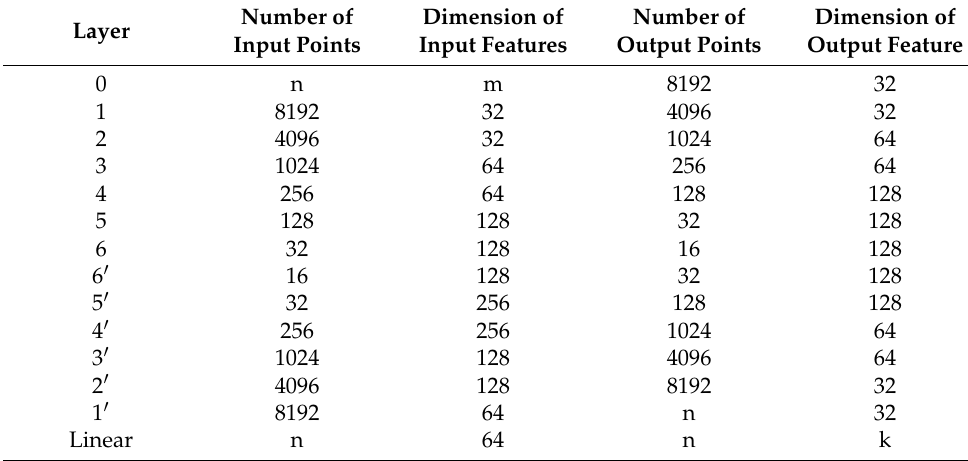
Table 1. The number of points and feature dimensions of input and output points of each convolu- tion